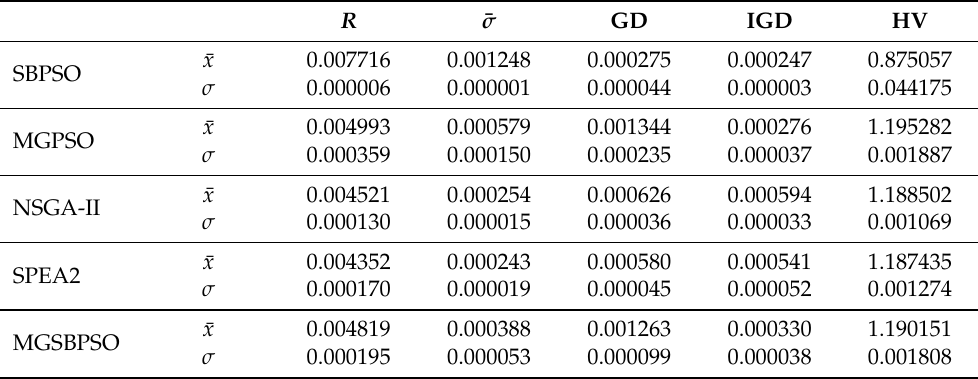
Table 11. S&P 100 results for each performance measure.